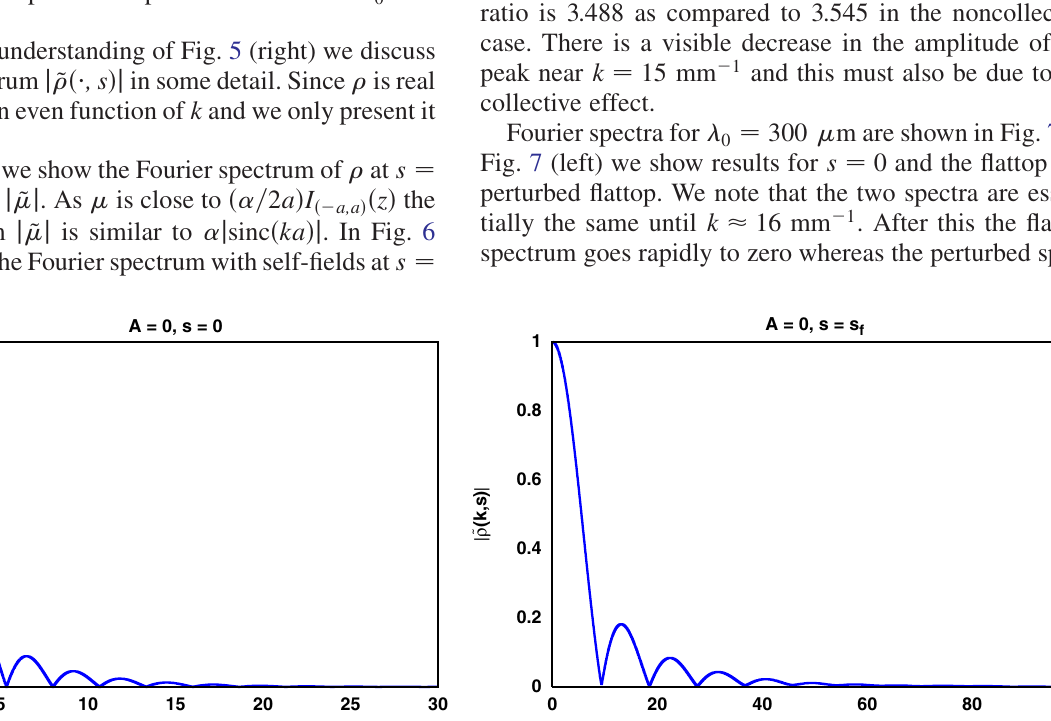
¼ 200 (cid:4) m . Right: 0 C and k (red squares) and f 0 0